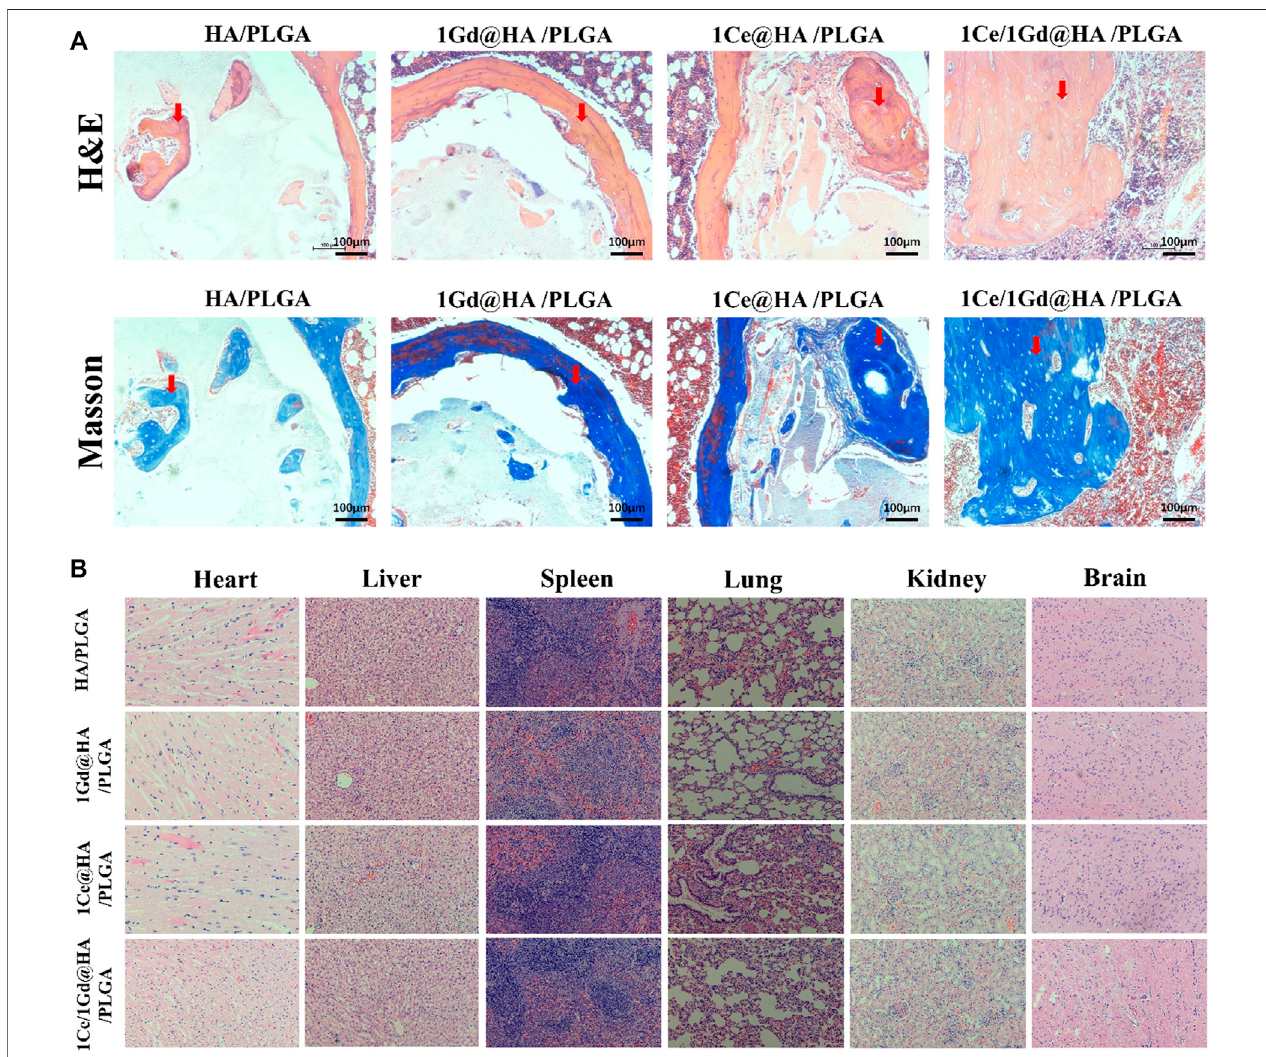
FIGURE 11 | (A) H&E and Masson trichrome staining of cross sections of tibial defects in rats after 8-week implantation. Scale bar, 100 μ m. Red arrows indicate newly formed bone. (B) H&E staining of rat ’ s heart, liver, spleen, lung, kidney, and brain 8 weeks after